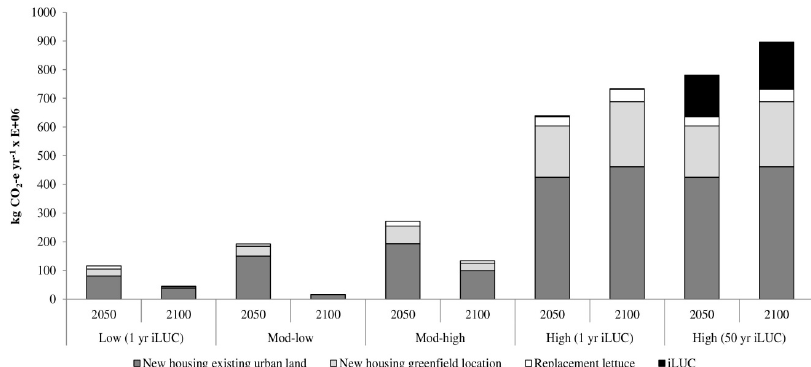
Figure 3. GHG emissions impact (kg CO 2 -e) per area of peri-urban (PU) land transformed for housing under the four future scenarios at time horizons 2050 and 2100. Contributions are displayed from the components: new housing in existing urban location; new housing in greenfield location; replacement lettuce; and